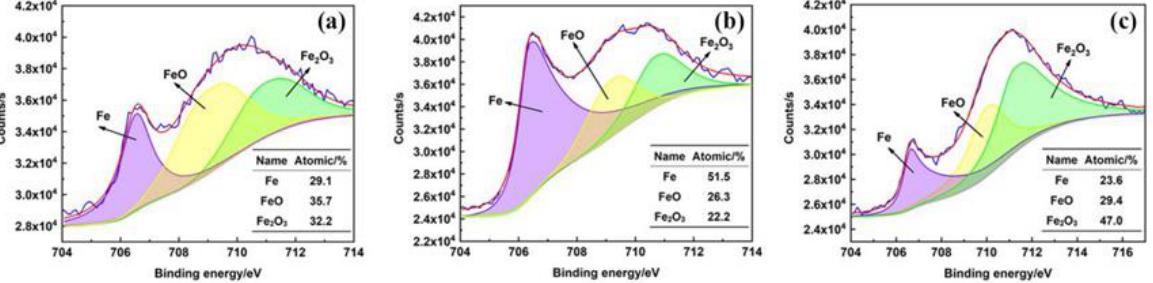
Figure 11. Fe2p peak fitting of 2205 DSS cladding layer under different current. ( a ) 90 A; ( b ) 100 A; ( c ) 110 A.